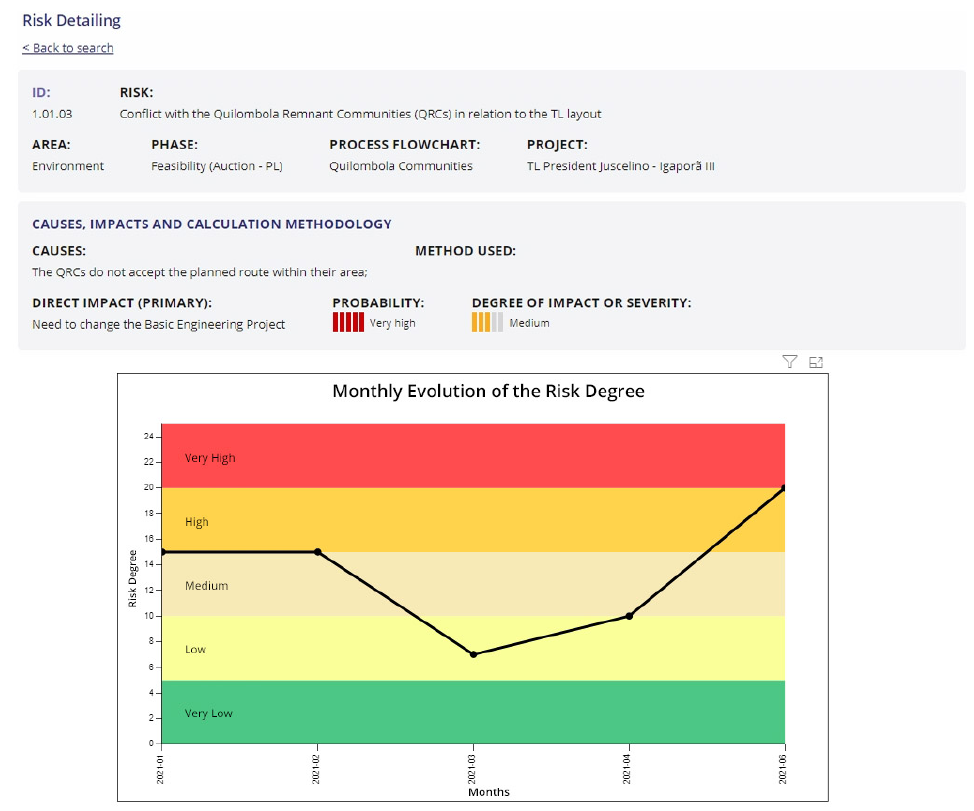
Figure 10. Web-based dashboard system displaying the risk